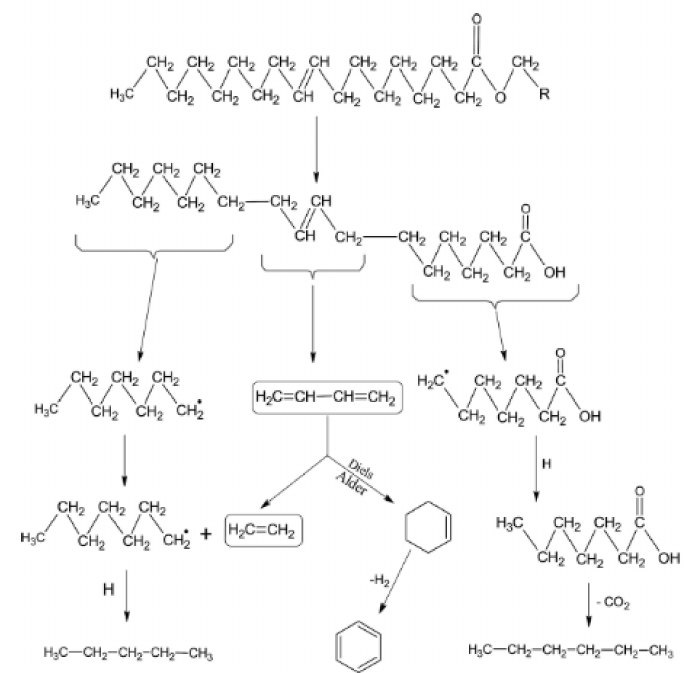
Figure 4. Thermal decomposition of triglycerides mechanism. Reproduced with permission from Ruhul et al., State of the art of biodiesel production processes: a review of the heterogeneous catalyst; published by RSC Advances, 2015